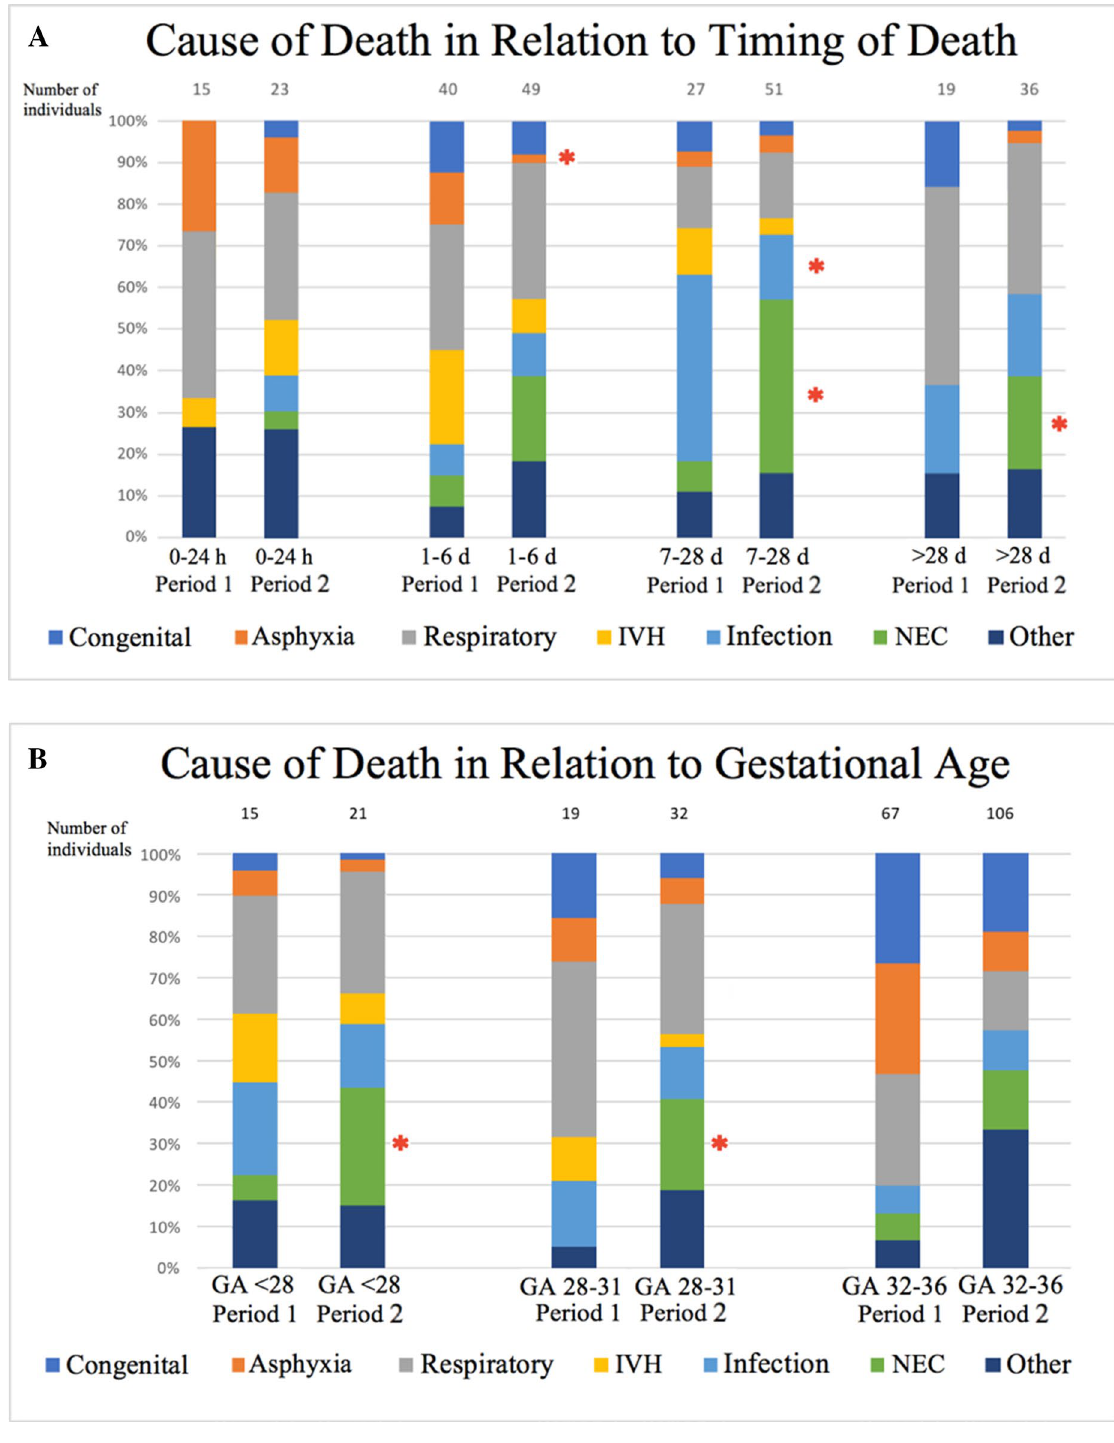
Figure 2. ( a ) Distribution in percent of causes of death at various time intervals (0–24 h; 1–6 days; 7–28 days; > 28 days) during Period 1 and Period 2. * p < 0.05; significant change between Period 1 and Period 2 within each time interval. Congenital, congenital anomalies; Respiratory, respiratory causes; IVH, intraventricular hemorrhage; Infection, infection with septicemia; NEC, necrotizing enterocolitis. See Table 4 for further categorization of causes of death. ( b ) Distribution in percent of causes of death at various degrees of immaturity (gestational age < 28 weeks, 28–31 weeks and 32–36 weeks) during Period 1 and Period 2. * p < 0.05; significant change between Period 1 and Period 2 within each degree of immaturity. GA; gestational age; Congenital, congenital anomalies; Respiratory, respiratory causes; IVH, intraventricular hemorrhage; Infection, infection with septicemia; NEC, necrotizing enterocolitis. See Table 4 for further categorization of causes of